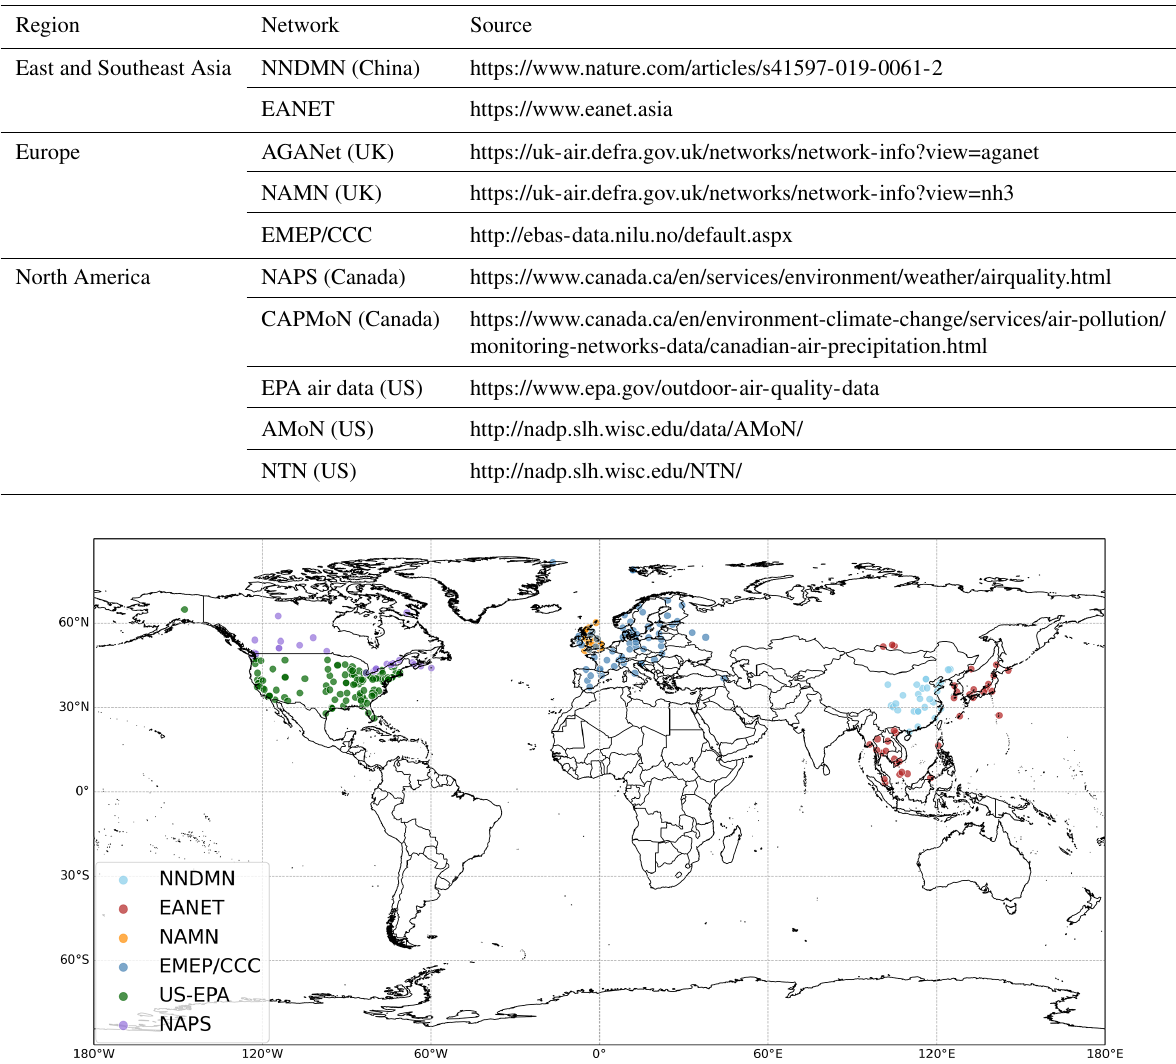
such as acid rain, smog, particulate matter, and mercury, in both air and precipitation. Regional precipitation and wet de- position data from CAPMoN were collected through wet pre- cipitation